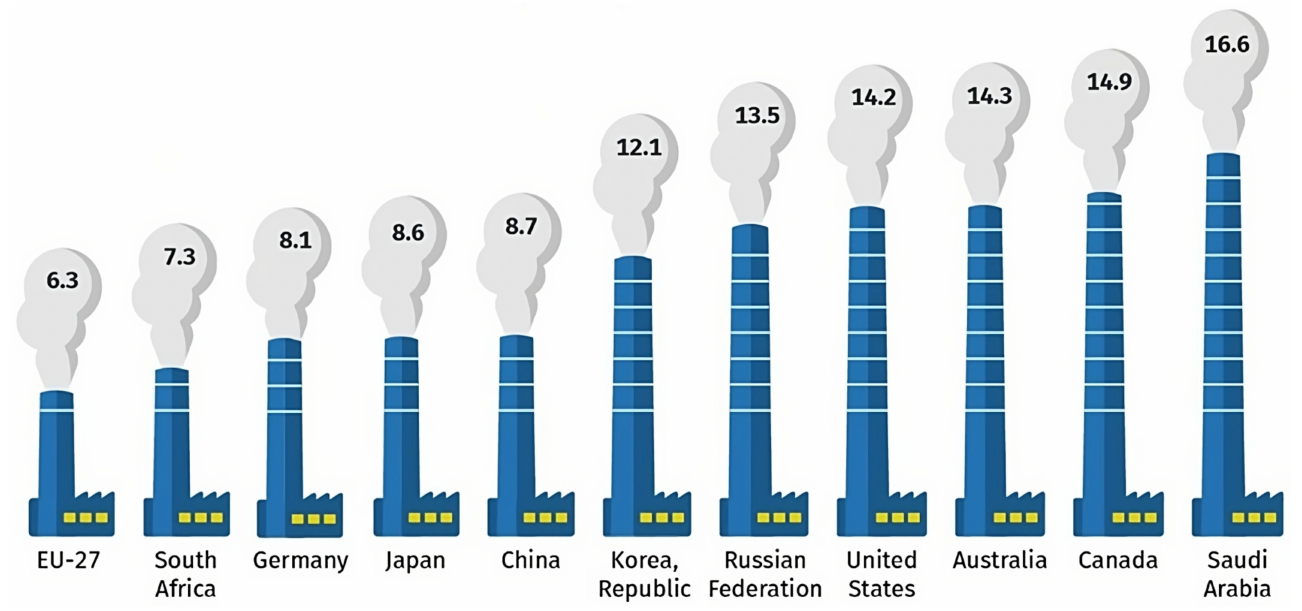
Figure 1. The main producers of CO 2 in metric tons. Source: